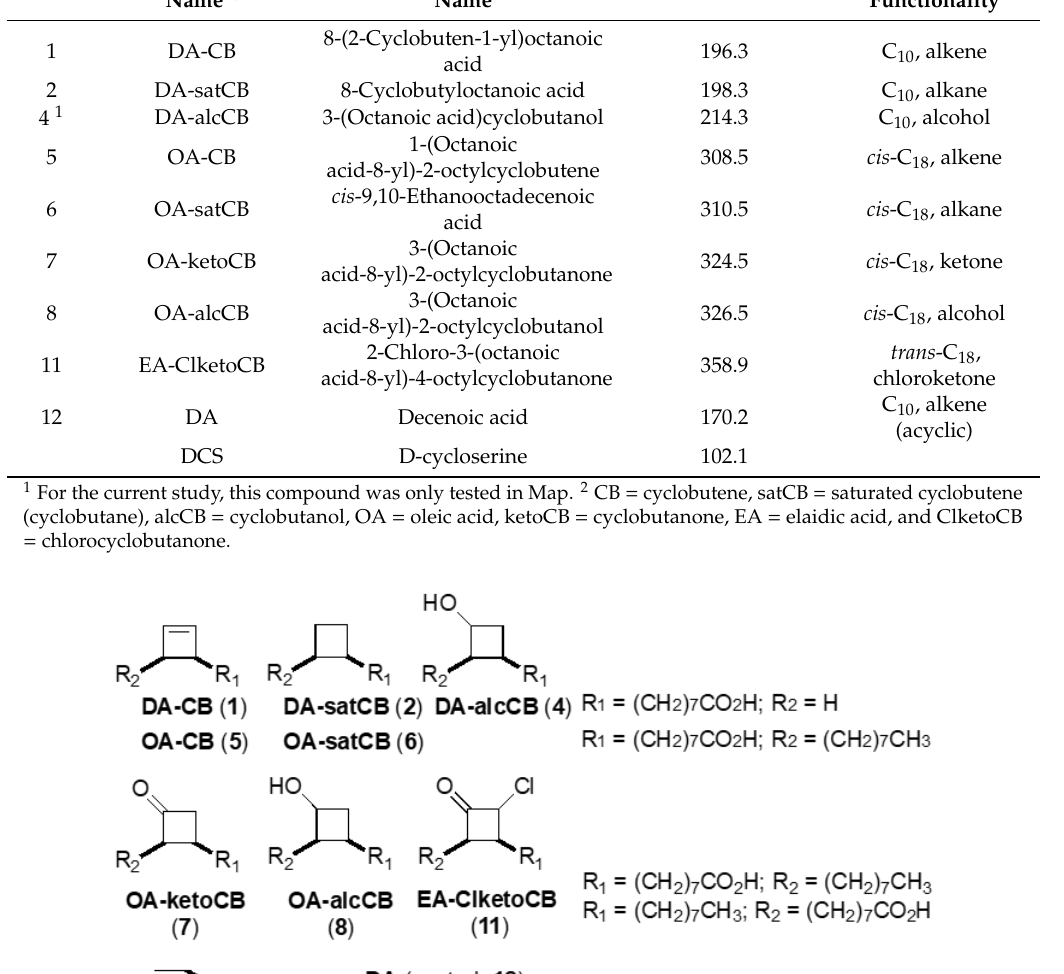
Table 1. Fatty acid derivatives used in this study.